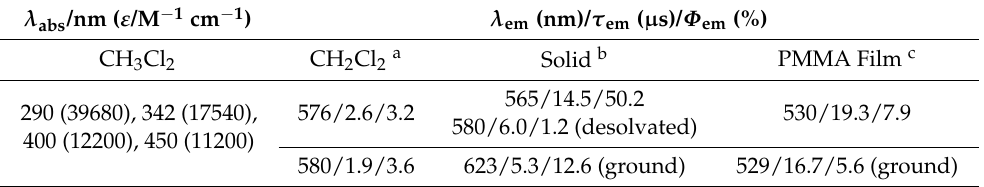
Table 1. The UV-Vis absorption and luminescent data of Au 4 Cu 2 cluster at ambient temperature.